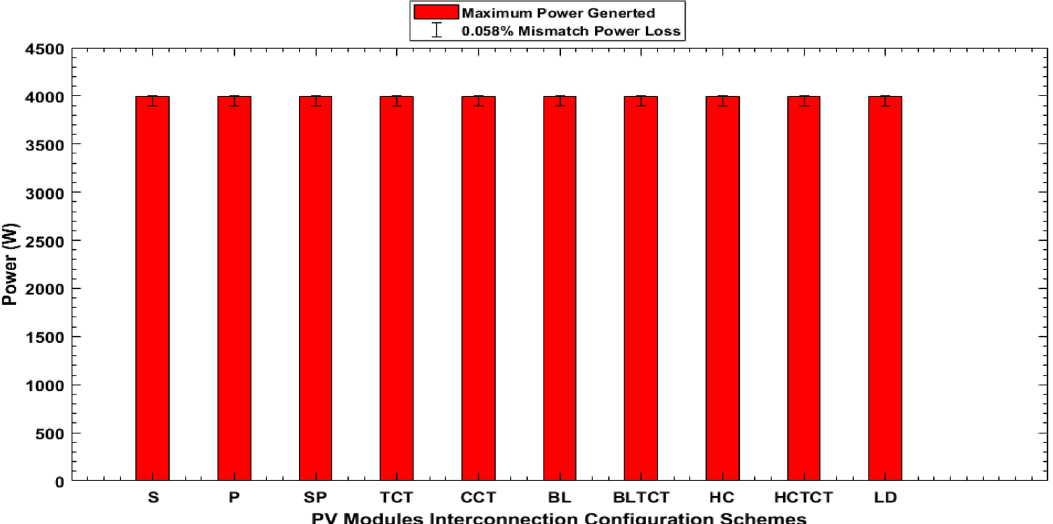
Fig. 10. Maximum power generation and mismatch power losses of PV modules interconnection con fi guration schemes under standard testing